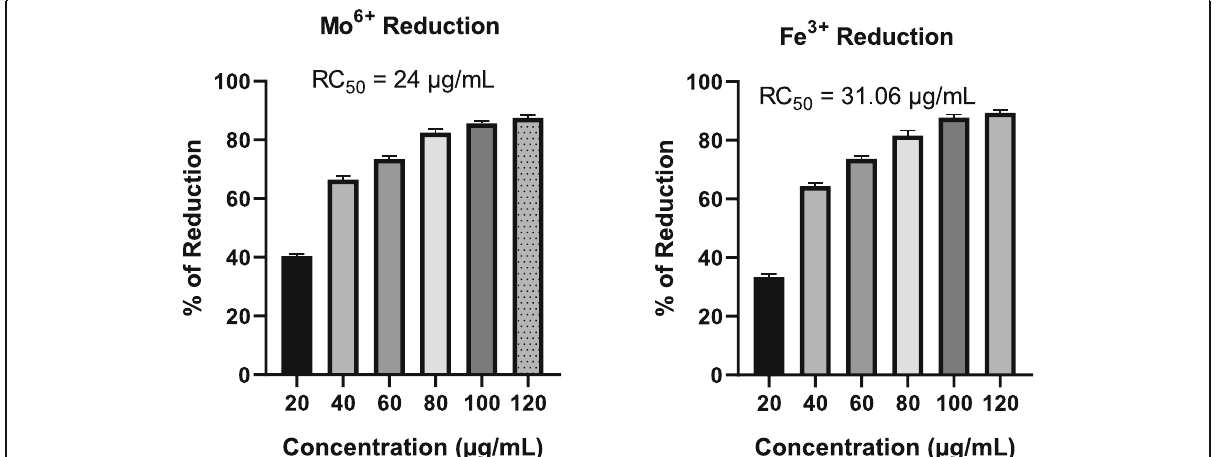
Fig. 4 Phosphomolybdenum reduction and Fe 3+ reducing power activity of the root extract of S. heyneanus . Statistical significance — for